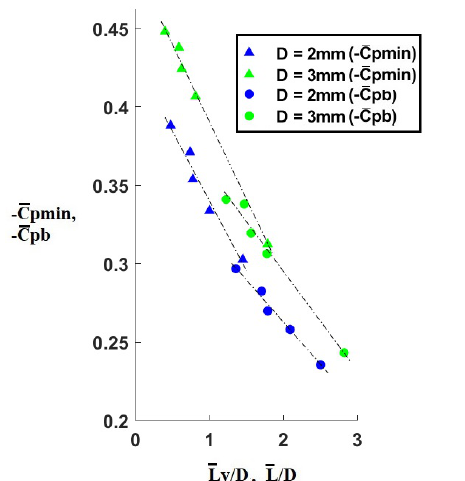
Figure 14. Simulated base suction pressure coefficient − ¯ C pb with respect to the length of the recirculation region ¯ L / D , as well as the minimum axis pressure coefficient − ¯ C pmin with respect to the wake formation length ¯ L v / D (exact values and the corresponding cases are shown in Table 5).